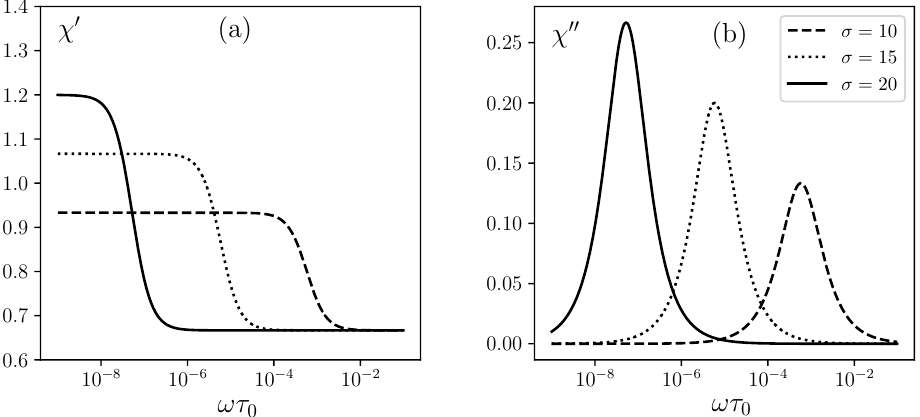
Figure 3. Frequency dependence of: ( a ) real χ (cid:48) and ( b ) imaginary χ (cid:48)(cid:48) parts of the magnetic suscepti- bility of an antiferromagnetic particle ensemble with a random distribution of the anisotropy axes; the temperature parameter σ is: 10 (dashes), 20 (dots), 30 (solid lines); the decompensation parameter β =